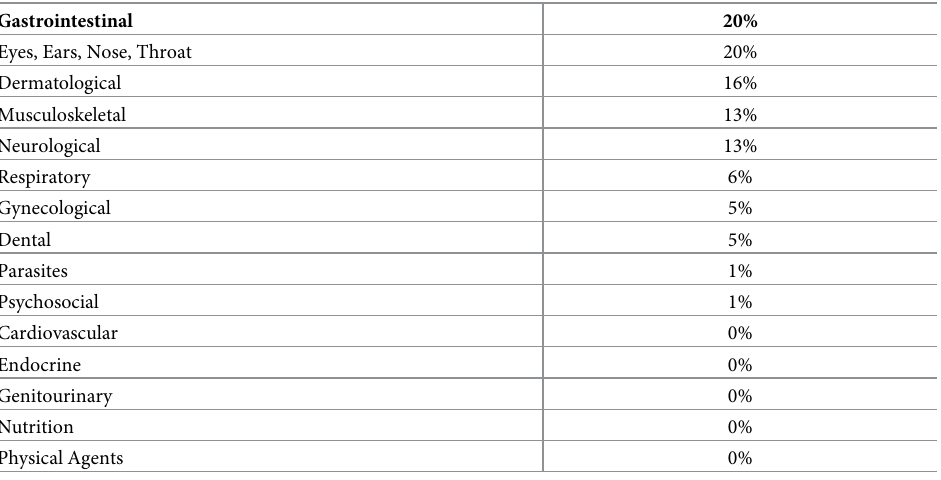
Table 2. Frequency of types of visits to the school